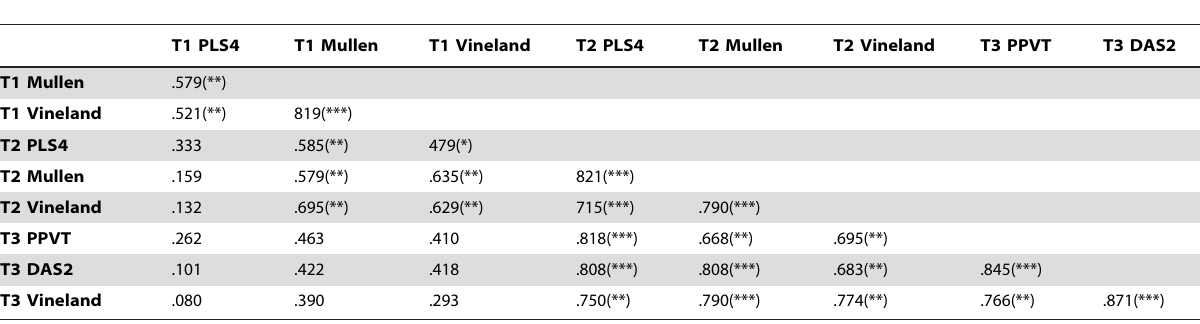
Table 3. Intercorrelations among outcome